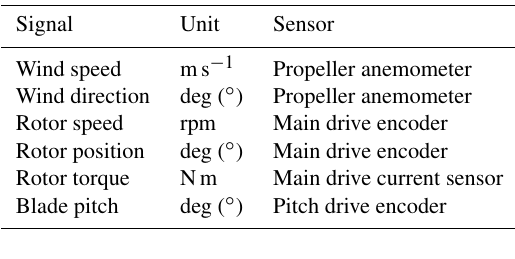
Table 2. List of signals to assess rotor power performance.